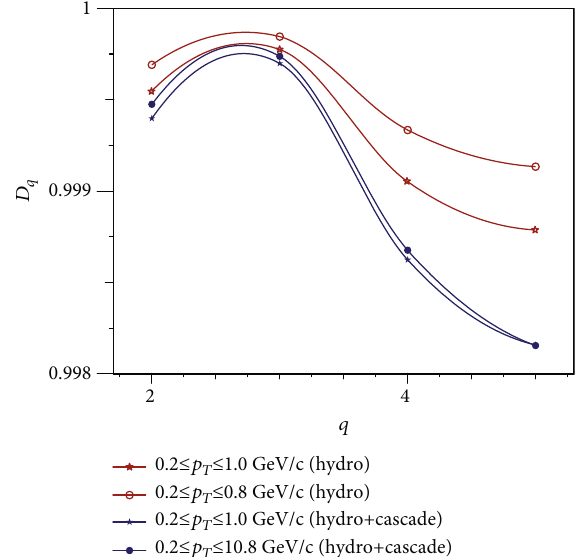
Figure 8: q dependence of fractal dimensions, D (hydro and hydro+cascade) events in the two p T bins in which weak M-scaling and F-scaling, is